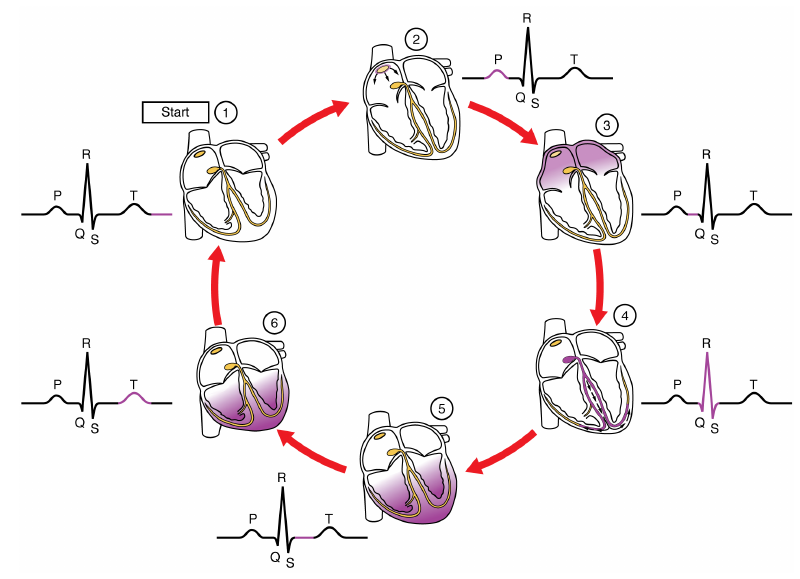
Figure 4. ECG waveform composition